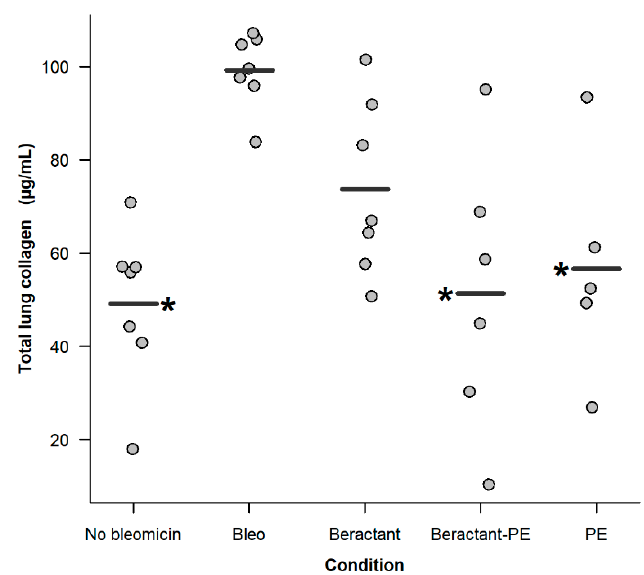
Figure 11. Effect of 1.5 mL of inhaled Beractant, phosphatidylethanolamine (PE)-enriched Beractant and PE on total lung collagen content in bleomycin treated C57/BL mice. The first dose was given the same day of bleomycin administration. Bleo : after intratracheal administration of 4 U/Kg bleomycin, 1.5 mL of normal saline was nebulized every 48 h for 6 doses. Beractant : after the administration of bleomycin, Beractant 400 mg/Kg were nebulized every 48 h for 6 doses. Beractant-PE : the treatment consisted of 400 mg mL − 1 of Beractant enriched with PE at a final concentration of 0.75 mg mL − 1 . PE : treatment consisted of phosphatidlethanolamine 0.75 mg mL − 1 . Lines represent the mean of the groups. Total collagen content was measured with the Sircoll assay (Biocolor Ltd., Northern Ireland, UK). (* p < 0.05, ANOVA with post-hoc Dunnett test against the saline-treated group).